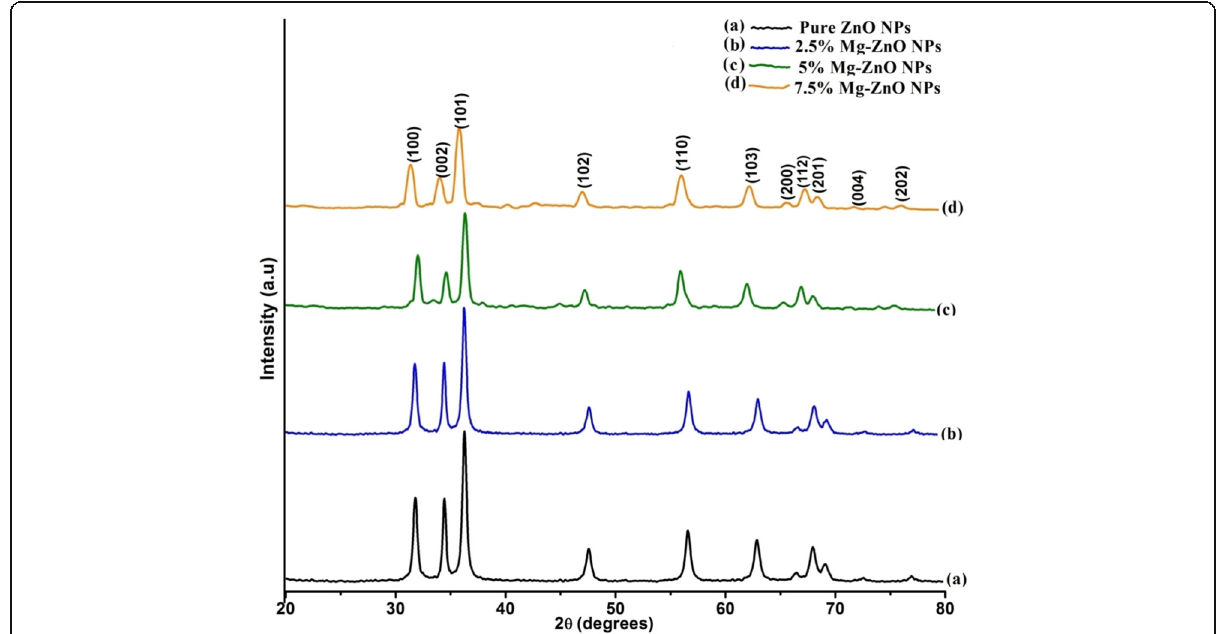
Fig. 2 XRD pattern for pure and Mg-ZnO NPs. a Pure ZnO NPs. b 2.5% Mg-ZnO NPs. c 5% Mg- ZnO NPs. d 7.5% Mg- ZnO NPs